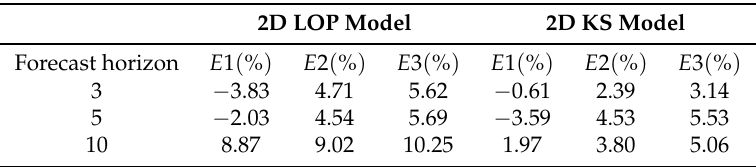
Table 3. Forecasting results of the 2D LOP model and the 2D KS model for GB males aged 50–89 based on mortality data since 1950.